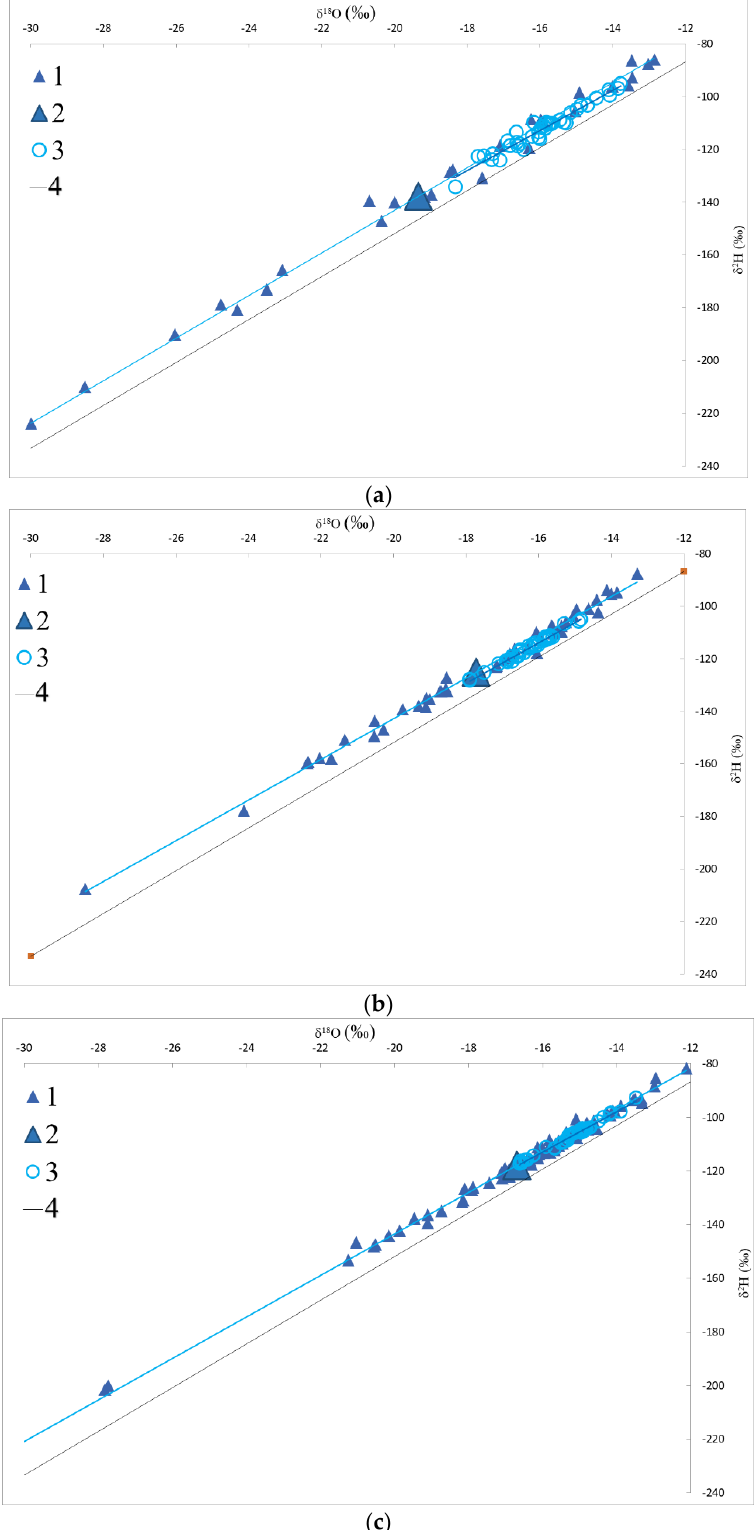
Figure 5. δ 18 O- δ 2 H relations for ice and meltwater in the Tavan-Bogd ( a ), Mongun-Taiga ( b ) and Tsambagarav ( c ) massifs. 1—ice from valley glaciers; 2—mean value of the ice samples; 3—meltwater; 4 —GMWL (δ 2 H = 8.14 δ 18 O + 10.9).